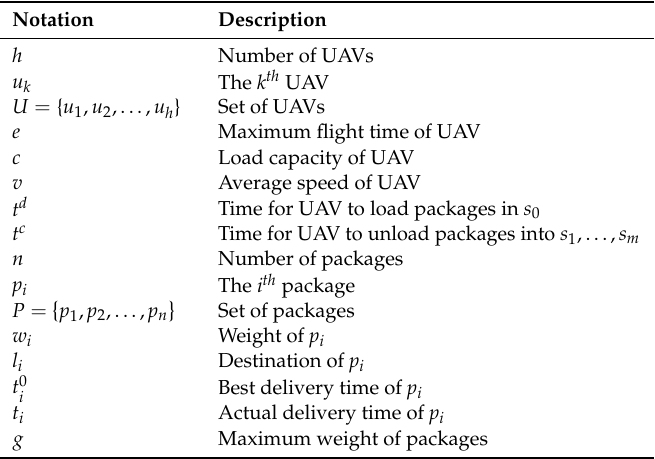
Table 1. Notations